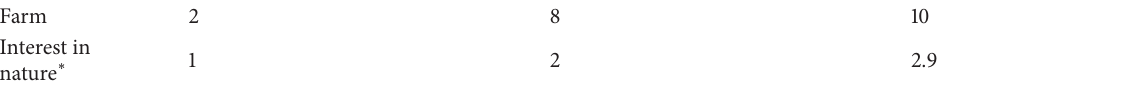
Table 3: Parts of the matrix used to classify farmers’ interest in nature. Here are examples from three farmers representing the three classes of interest in nature and their quotes for 8 of 11 subject